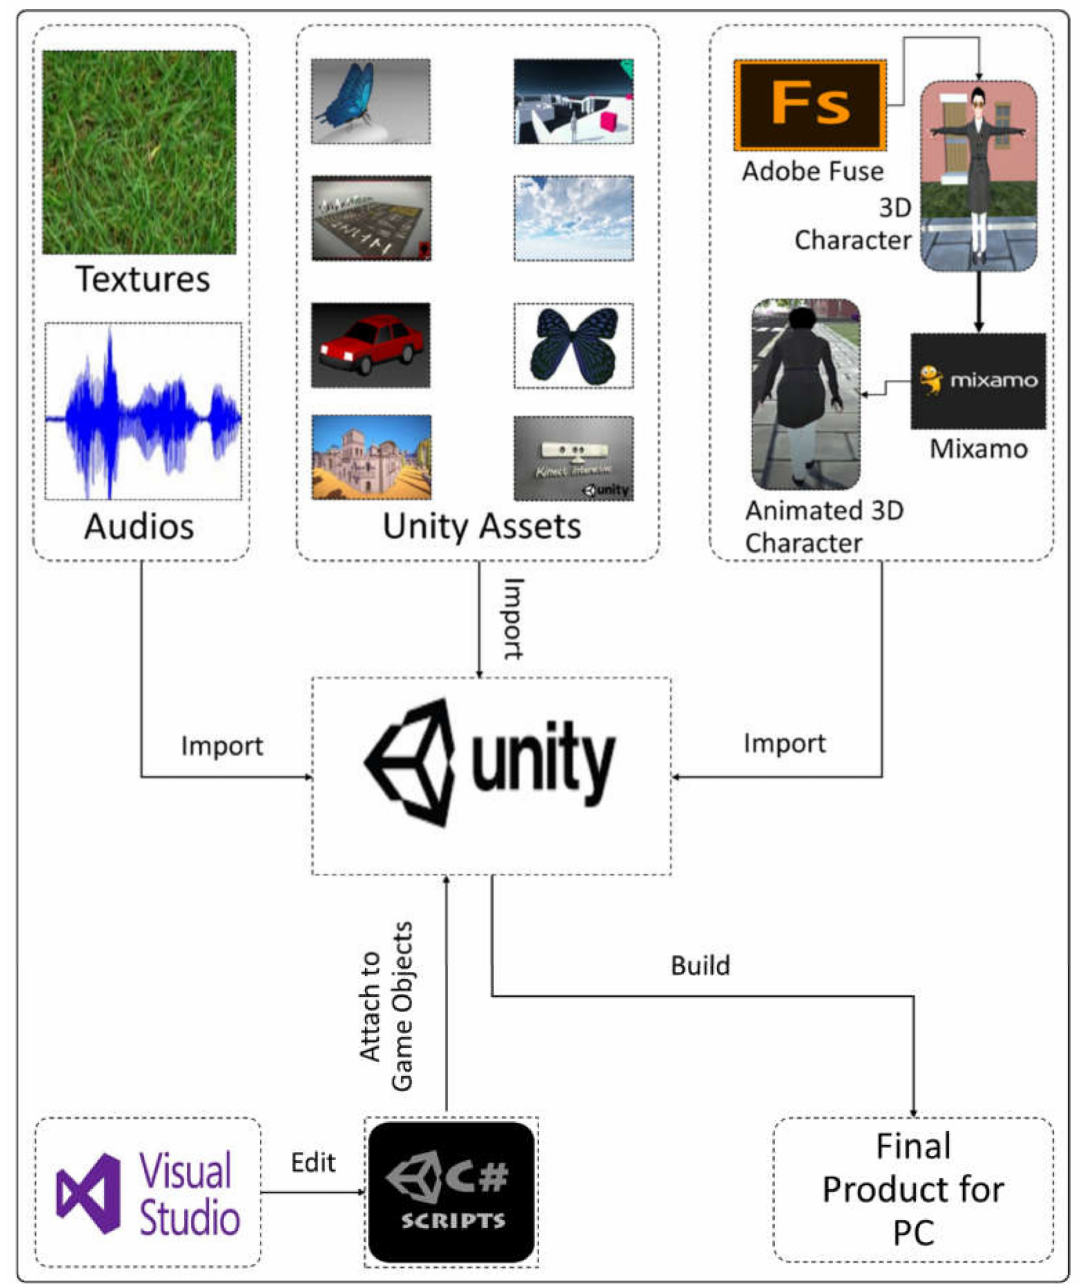
Figure 2. The development flow of our proposed system, wherein we picked Unity as the game engine with Unity assets, third-party 3D models, audios, textures, and existing Kinect plug-ins downloaded in compatible formats and imported into Unity. The 3D character models are designed in Adobe Fuse and animated with the Maximo third-party application. C# is used as the programming tool for logic